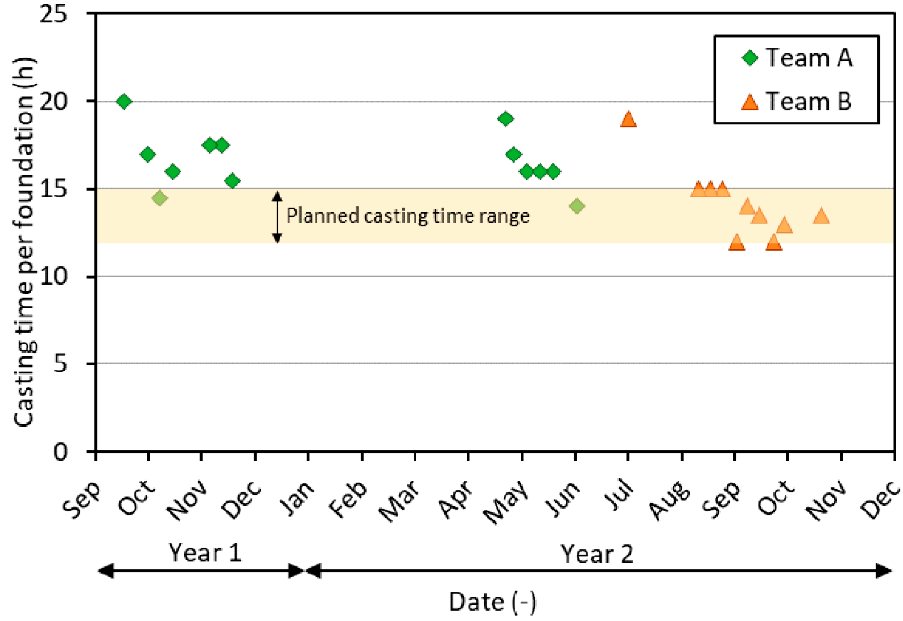
Figure 10. Relation between the time required for casting the foundation and their production date.